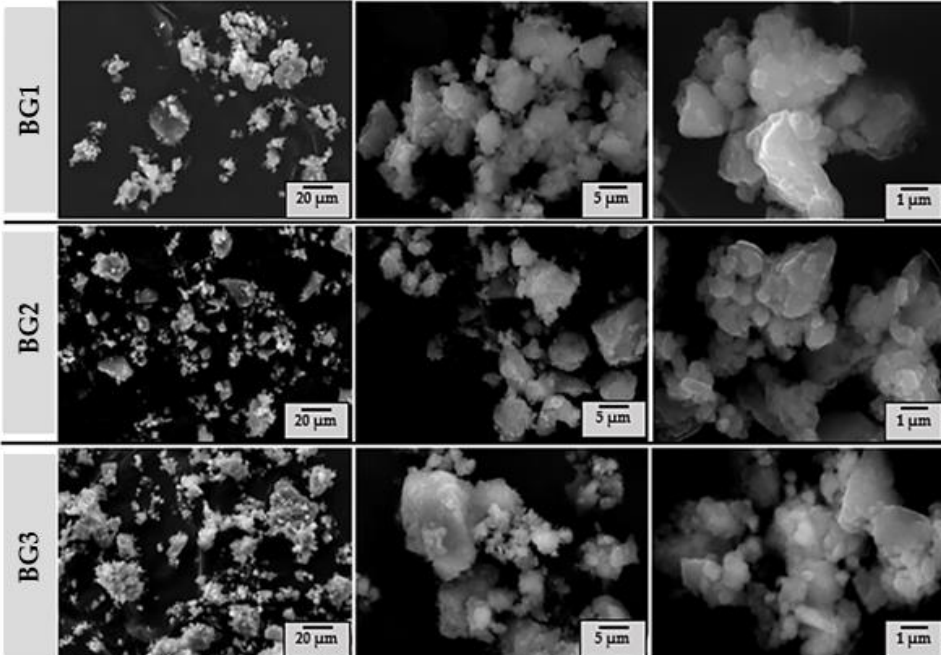
Figure 5. SEM micrographs of the BG powder samples (BG1 – 3) calcined at 700 °C.